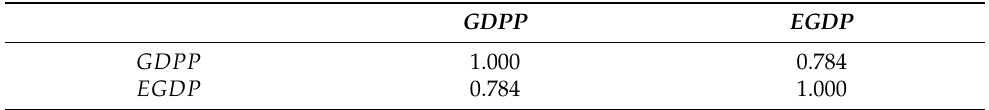
Table 6. The results of Correlation Coefficient of Regression Variables.